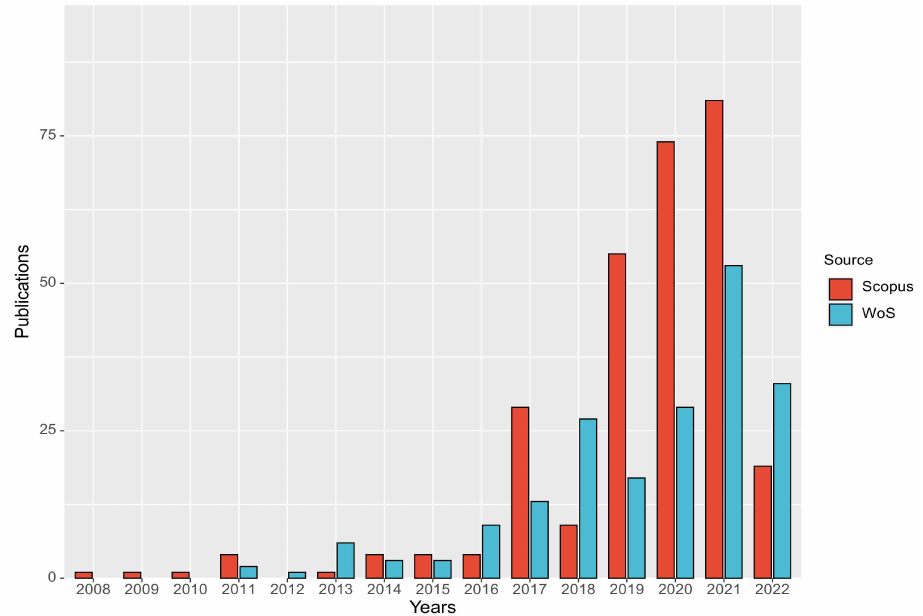
Figure 3. Annual Publications in the WoS and